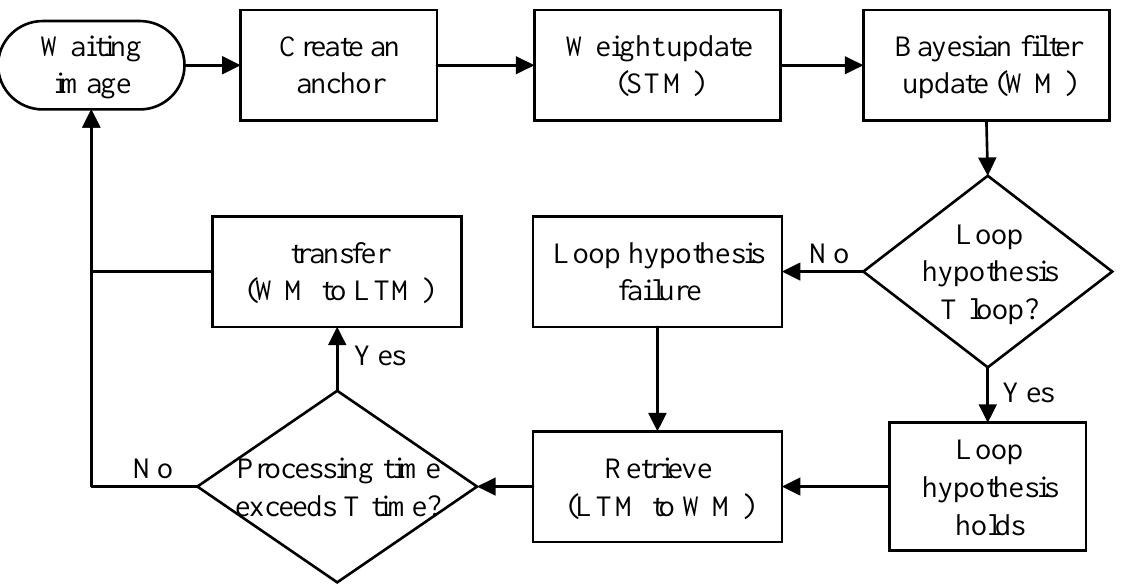
Figure 16. Flow chart of the loop closure detection by RTAB-map.